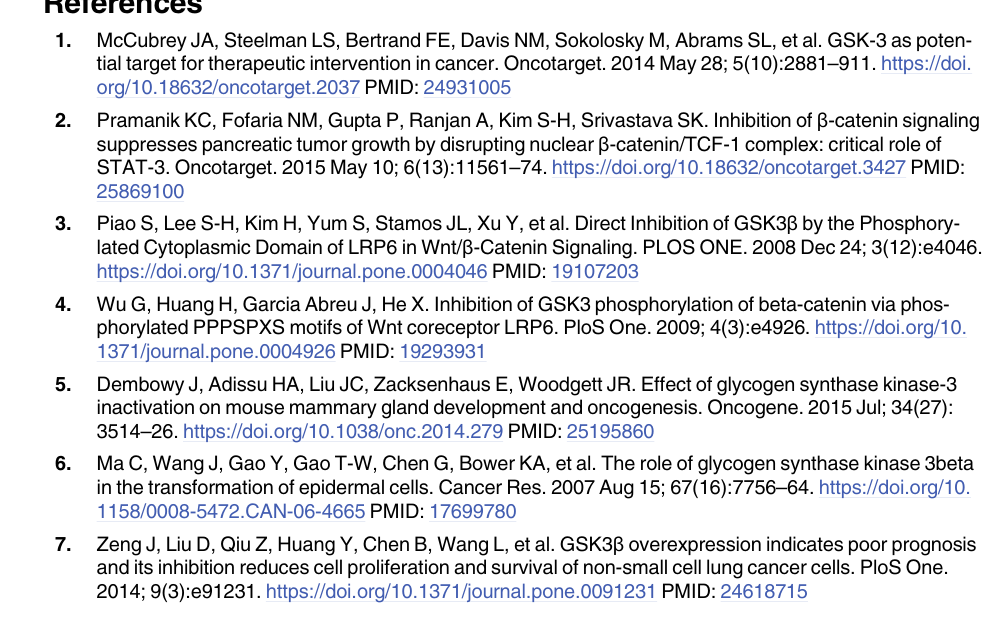
S1 File. Supplementary table of protein quantification of HCT116-GSK3 β -WT and HCT116-GSK3 β -KO cells by mass-spectrometry. S2 File. Supplementary table of enriched pathways from the mass-spectrometry